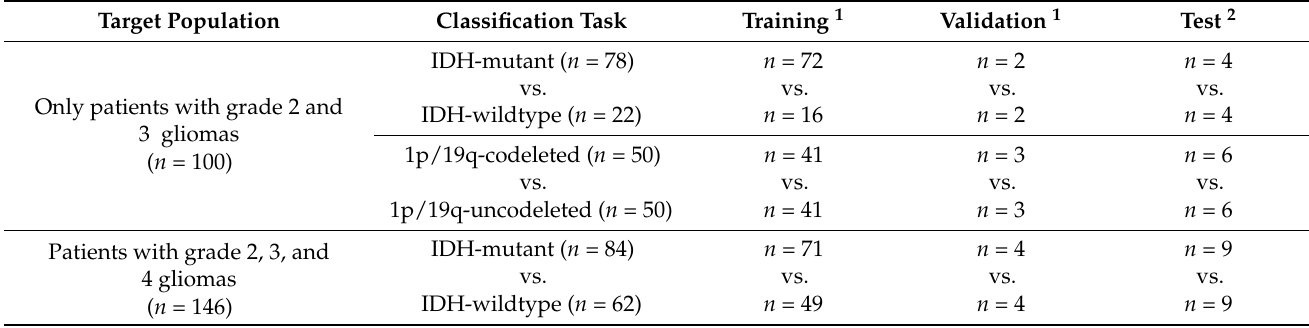
Table 2. Class distribution in training, validation, and test sets for each classification task. Target